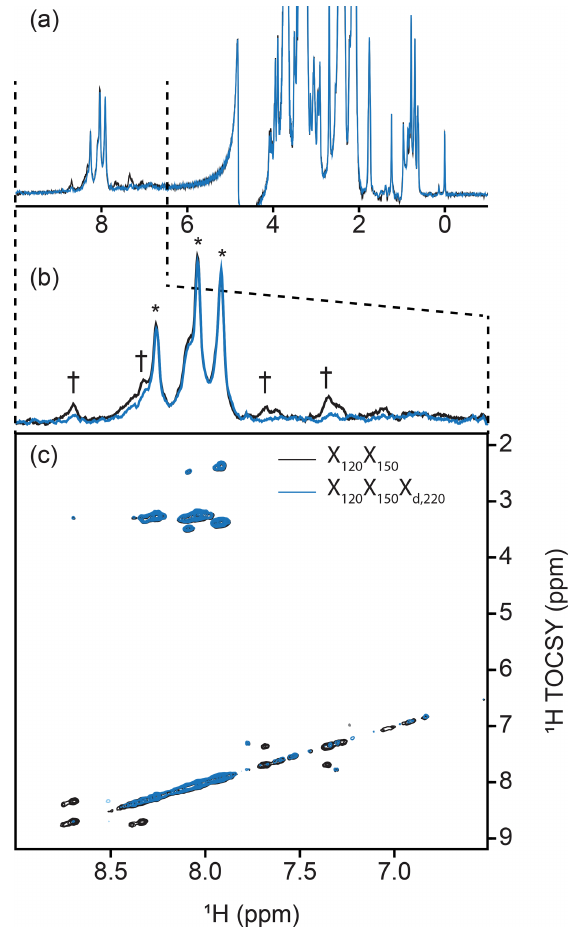
Figure 5. Implementation of delayed decoupling into 2-D homonu- clear TOCSY. X 150 X 120 TOCSY was recorded with (blue) and without (black) a X d , 220 filter for enhanced suppression of aromatic signals. (a) 1-D trace of the detected dimension. The aliphatic re- gion is identical in both spectra but X d improves the suppression of aromatic signals. (b) Zoom of the spectral region from 6.5 to 9.0ppm emphasizing the reduction of aromatic signals. Daggers denote aromatic signals from PCP1 that are not suppressed in the TOCSY-X 120 X 150 experiment lacking X d . Asterisks denote signals from the prosthetic that are preserved. (c) Cross peaks between aro- matic signals of PCP1 are largely suppressed in the 2-D TOCSY upon addition of our delayed decoupling technique with no loss in signal sensitivity for unlabeled